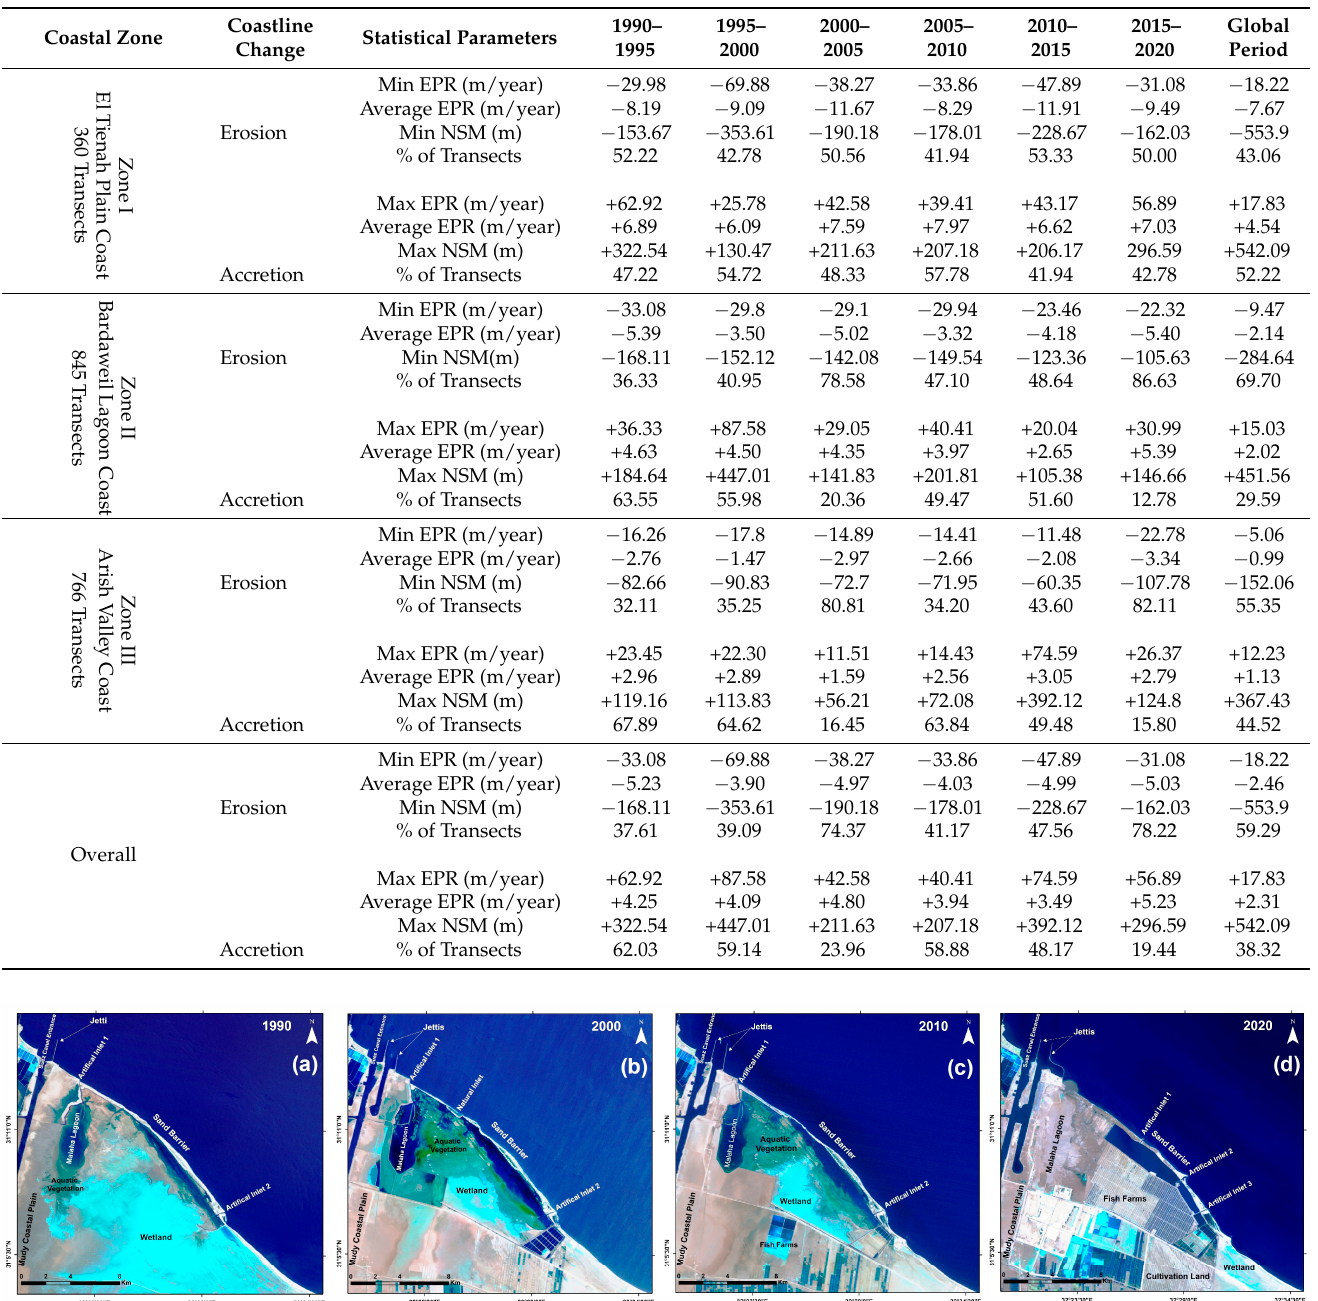
Table 4. Coastline change statistics between 1990 and 2020.